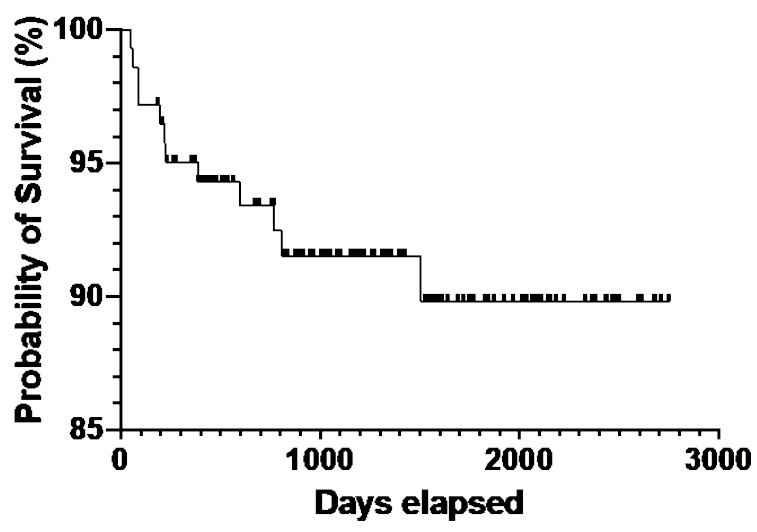
Figure 1. Overall survival of CTCL in Arkansas by Kaplan–Meier analysis.